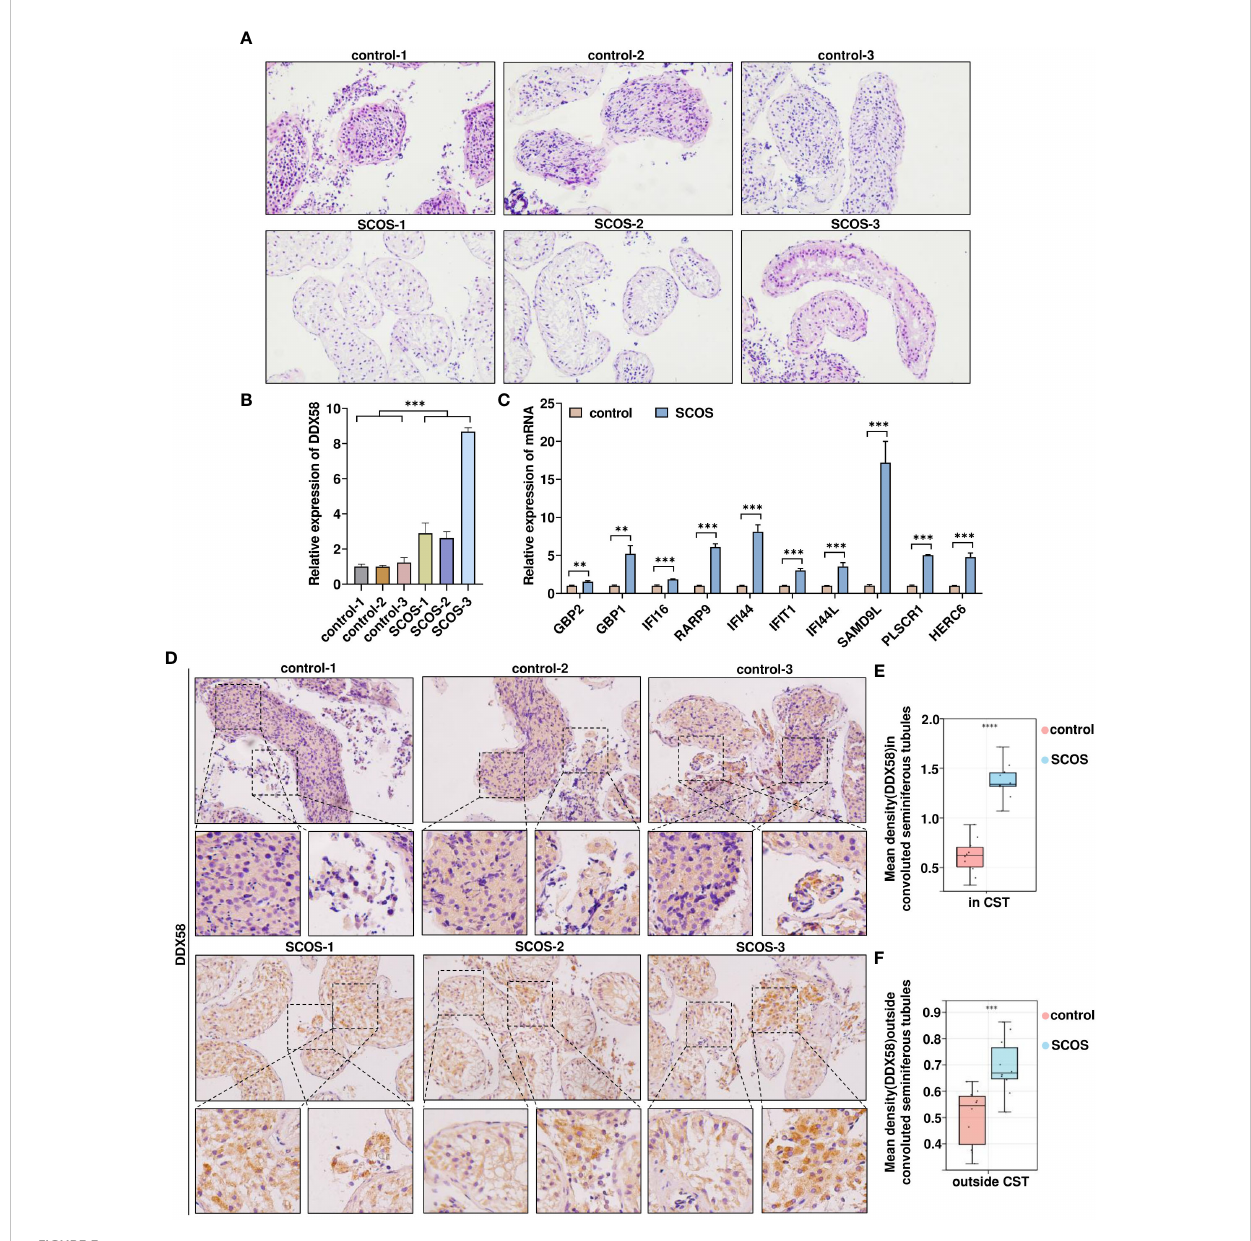
FIGURE 3 Elevated DDX58 expression in testicular tissue of patients with SCOS. (A) SCOS testis and spermatogenic normal testis, HE of hematoxylin and eosin. (B) RT-qPCR was used to detect DDX58 mRNA expression in testicular tissue. ***p < 0.001 vs . the control group. (C) RT-qPCR was used to detect mRNA expression of other 10 genes belonging to module 3 in testicular tissue. **p < 0.01, ***p < 0.001 vs . the control group. (D) Immunohistochemical staining of DDX58 in testes with OA and SCOS. Scale bar: 50 m m. Original magni fi cation: ×200(n= 10). (E) Average DDX58 staining intensity in CST (n= 10). (CST, convoluted seminiferous tubule) ***p < 0.001 vs . the control group. (F) Average DDX58 staining intensity outside convoluted seminiferous tubules (n= 10). ****p < 0.0001 vs . the control